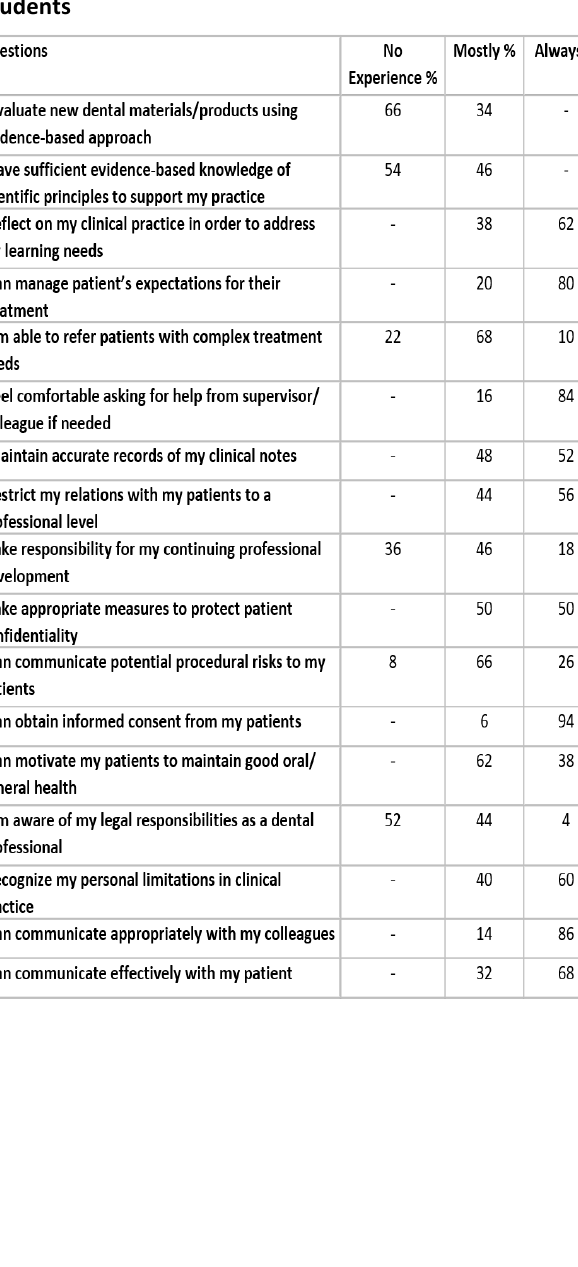
8: Self-perceived preparedness to cognition, communication and professional skills based on gender profile among the final year students.